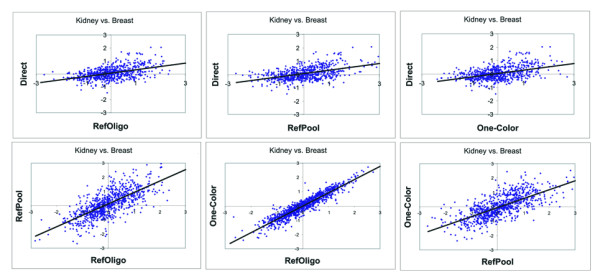
Correlation between direct and reconstructed ratios. Ratio plots from Kidney vs. Breast comparisons are shown. Upper panels: scatter plots between direct ratios and each of the three reconstructed ratios (RefOligo, RefPool, One-Color). Lower panels: scatter plots between the reconstructed ratios. Ratio plots for the remaining tissue comparisons are shown as supplementary material [see Additional file 2]. In all cases, only ratios from spots with intensity values 2 SD above the average slide background were used.